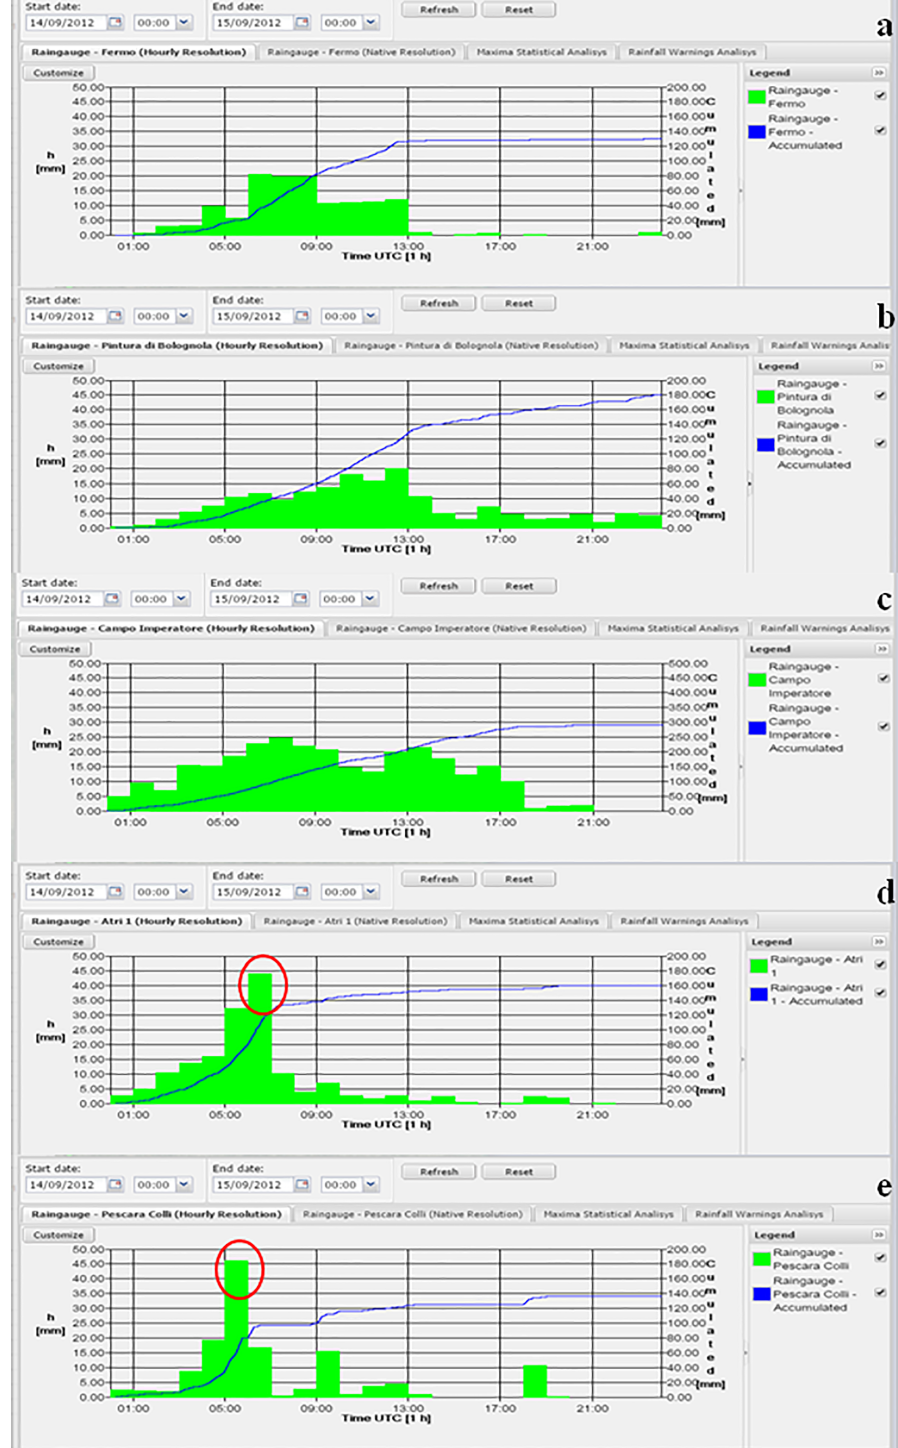
Figure 3. Rain gauge time series of some selected stations in Marche ( a , Fermo; b , Pintura di Bolognola) and Abruzzo ( c , Campo Imperatore; d , Atri; and e , Pescara Colli) regions during the event of 14 September 2012. The green histogram represents the hourly accumulated precipitation (scale on the left); the blue line represents the incremental accumulation within the 24h (scale on the right). (Courtesy of Italian Civil Protection